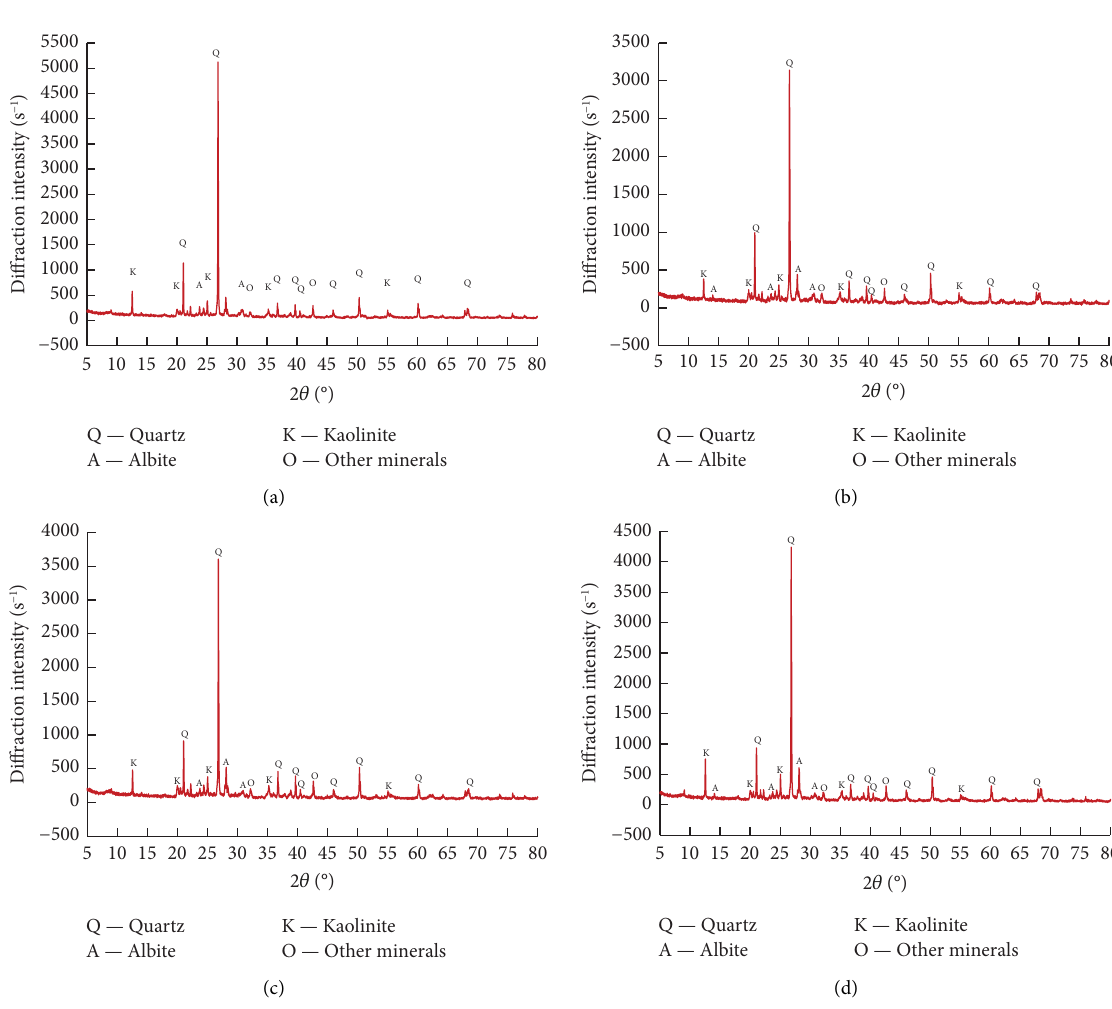
Figure 1: X-ray diffraction spectrum. (a) Uncorroded. (b) pH � 7. (c) pH � 9. (d) pH � 12.